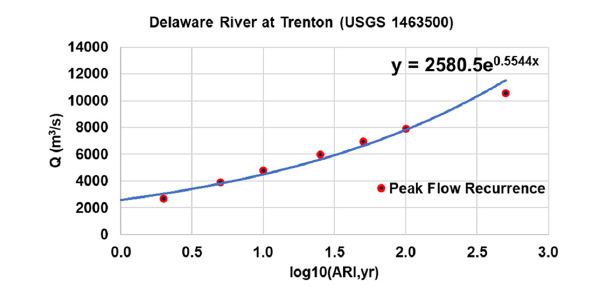
FIGURE 14 | Flood frequency chart of the Delaware River based on USGS